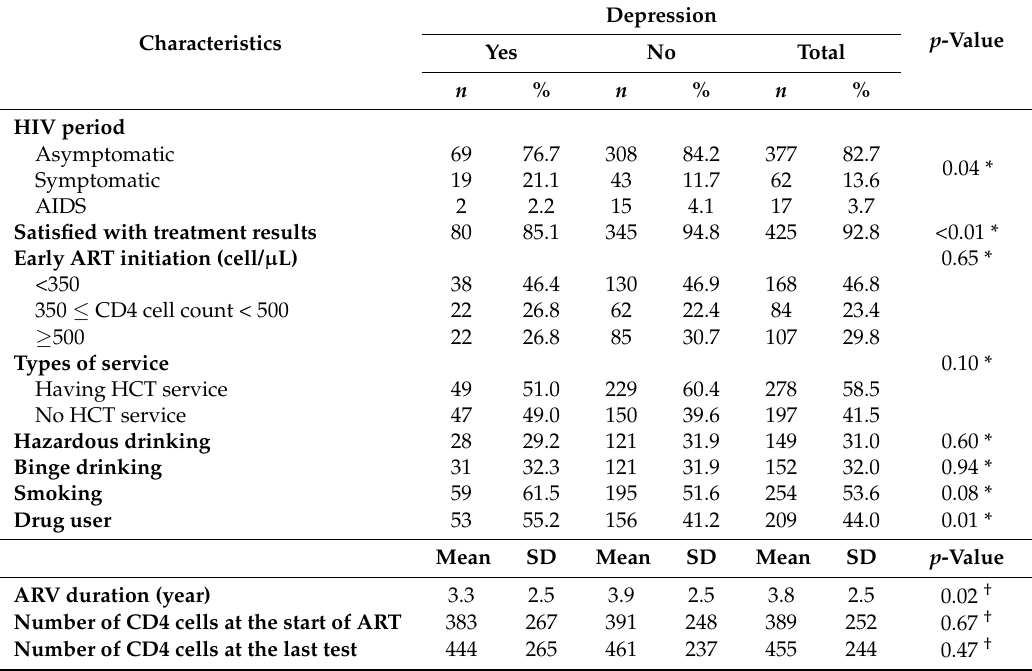
Table 2. Antiretroviral therapy and substance abuse status ( n = 482).